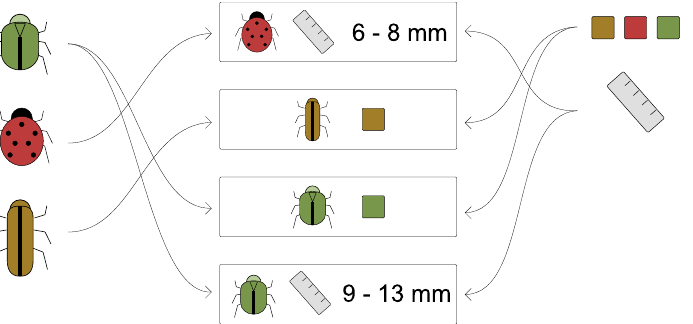
Fig 1. The core concepts of any Clavis key. Taxa (left) and characters (right) are connected through statements (center). Each statement refers to one taxon and one character, linking the two by a value, usually one of the possible states of the character, or a numerical value or range.